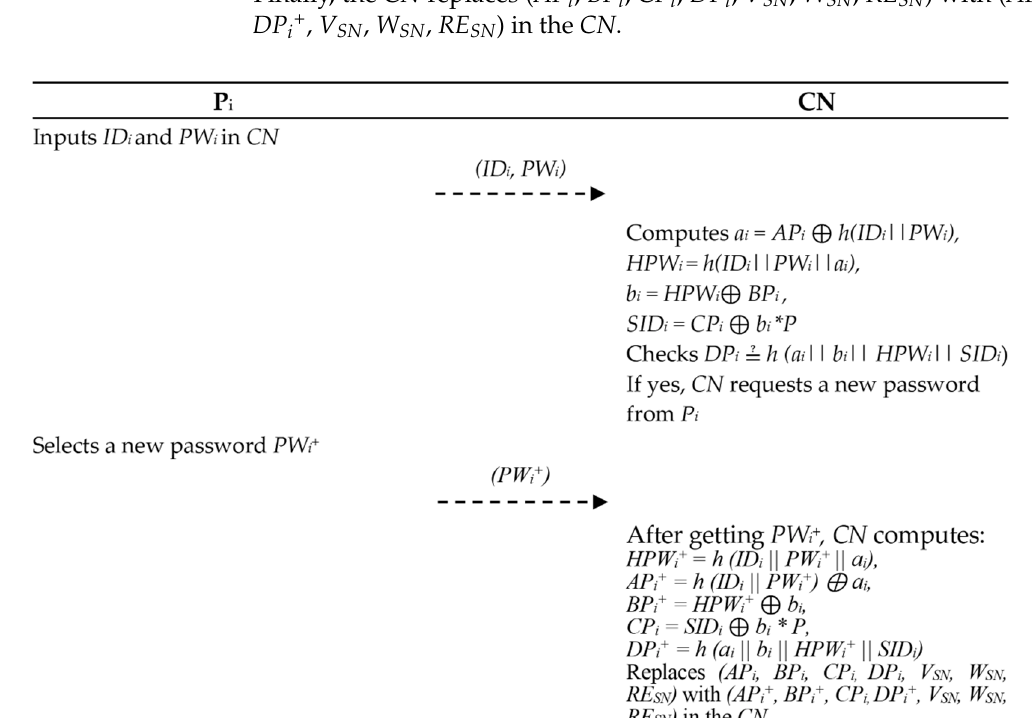
Figure 5. Change password